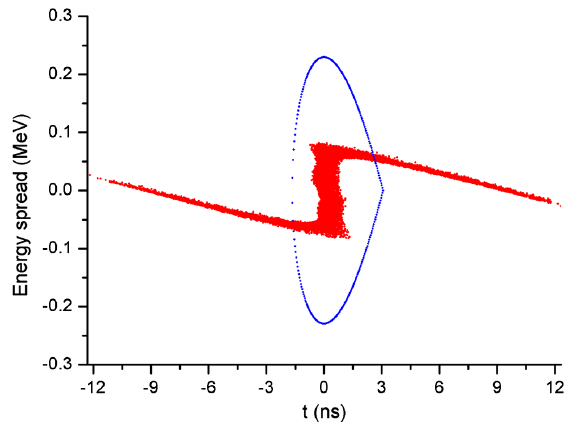
FIG. 24. Expected longitudinal distribution at the RFQ entrance of the beam bunched by the MHB and the initial reduced-size separatrix of the longitudinal motion.